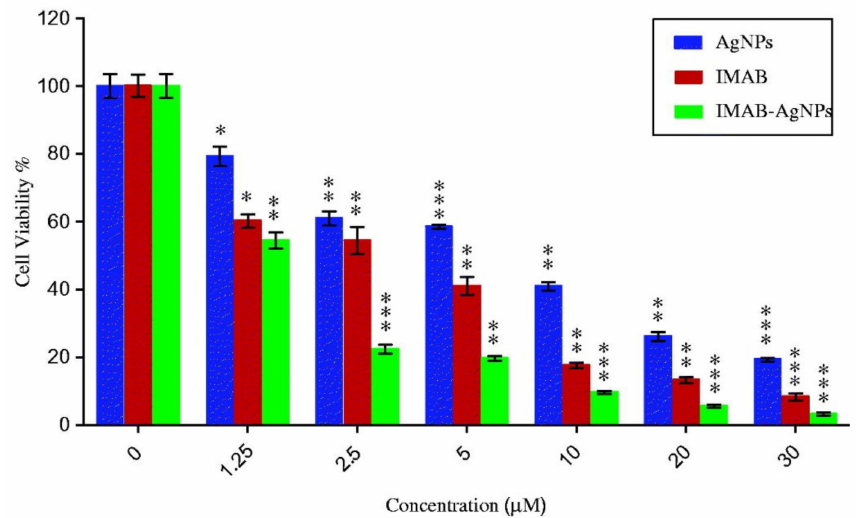
Figure 10. Influence of AgNPs, free IMAB, and IMAB-AgNPs on MCF-7 cancer cells, at different concentrations (0, 1.25, 2.5, 5, 10, 20, and 30 µ M) and after incubation of 24 h. Statistical significance analyzed with Student’s t-test at different levels: * p < 0.05, ** p < 0.01 and *** p < 0.001. Reprinted from [40], with permission of the publisher Taylor & Francis Ltd.,